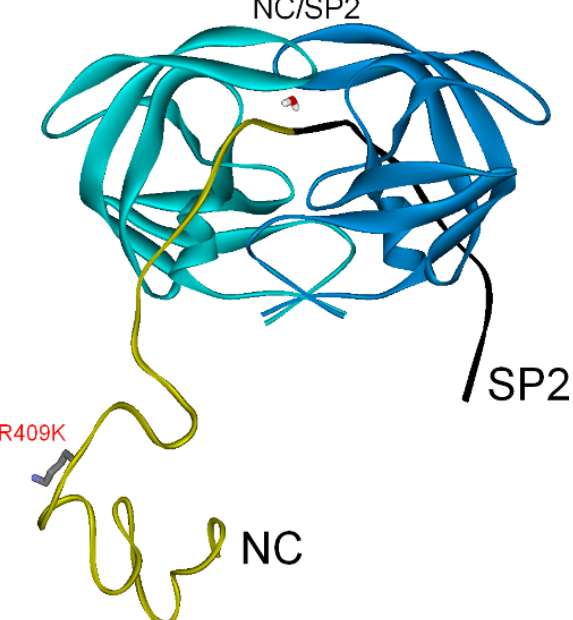
Figure 8. HIV-1 PR (front view) bound to NC/SP2 cleavage site in NC-SP2 protein, PR backbone as ribbon (A-subunit teal, B-subunit blue), NC-SP2 protein backbone ribbon (NC yellow, SP2 black), NC/SP2 cleavage site indicated. Gag non-cleavage site PI resistance residue NC R409K residue shown (red label), with tetrahedrally coordinated active site water indicated (carbon grey, oxygen red, and nitrogen blue).